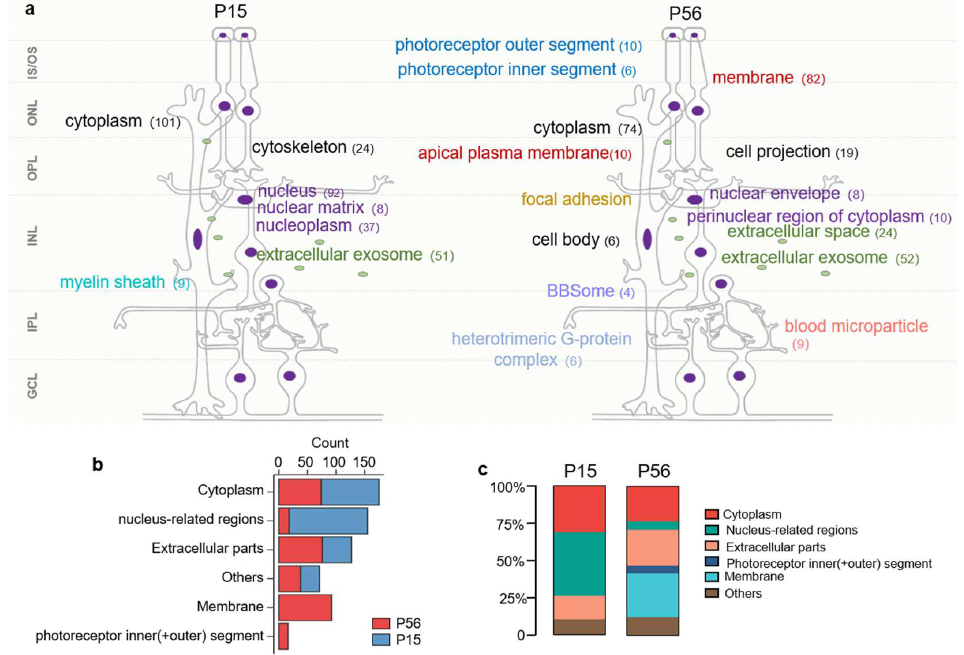
Figure 6. GO subcellular location analysis of the DEPs. ( a , b ) Detailed subcellular locations ( a ) and statistics histogram ( b ) of the DEPs in RS1-KO retinas at P15 (left) and P56 (right). The number of enriched proteins is labeled after the specific subcellular location. Notably, protein locations do not represent cell type information. ( c ) Composition ratio histogram of DEPs at P15 (left) and P56 (right). RGS, reactome gene sets; BP, biological process.